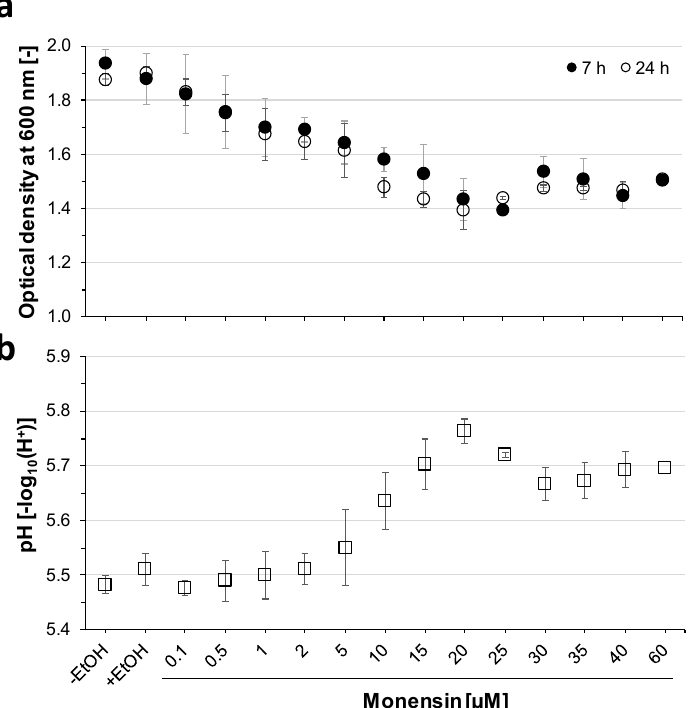
Figure 1. Optical density and pH values of P. bryantii B 1 4 using a range of monensin concentrations in Hungate tube cultures. ( a ) Mean optical density (OD) after 7 h (black) and 24 h (white) of incubation are given with error bars for standard deviation (n = 3). No significant difference was observed between 7 and 24 h (ANOVA: p = 0.486). ( b ) The pH average after 24 h (white squares) of incubation are given with error bars for standard deviation (n = 3). Two controls without monensin excluded or included ( − /+) EtOH. Significances were proven by Fisher LSD-test ( p < 0.01).